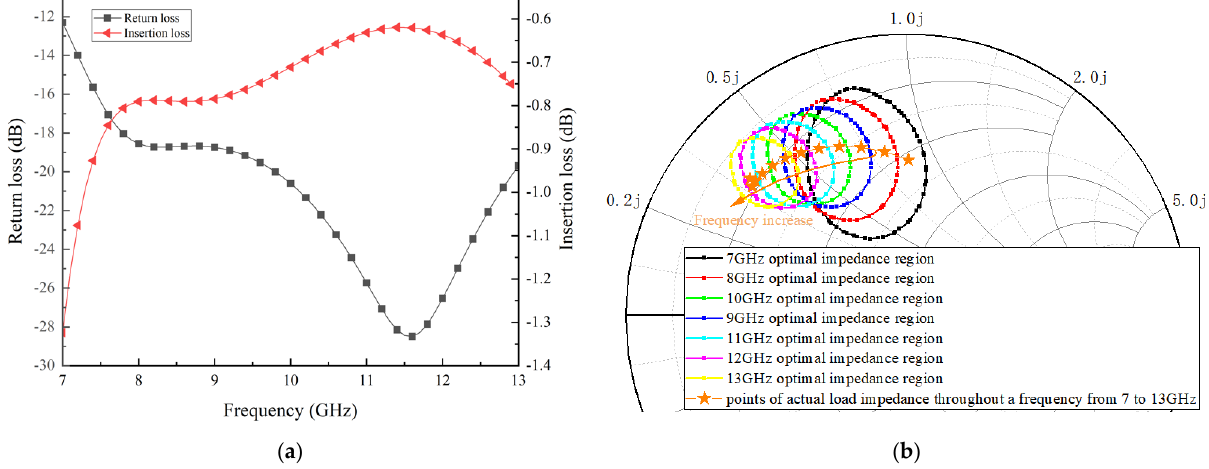
Figure 8. Simulation result of the OMN: ( a ) insertion loss and return loss; ( b ) points of actual load impedance.